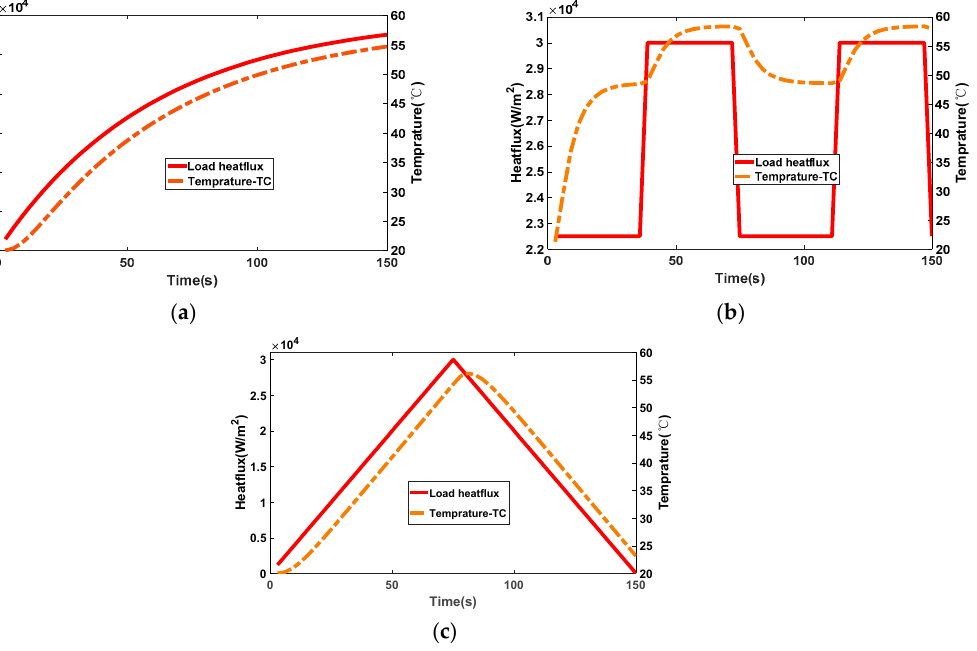
Figure 4. Temperature change of the measurement point under the action of heat flow in three different types. ( a ) Triangle; ( b ) square; ( c ) exponential.